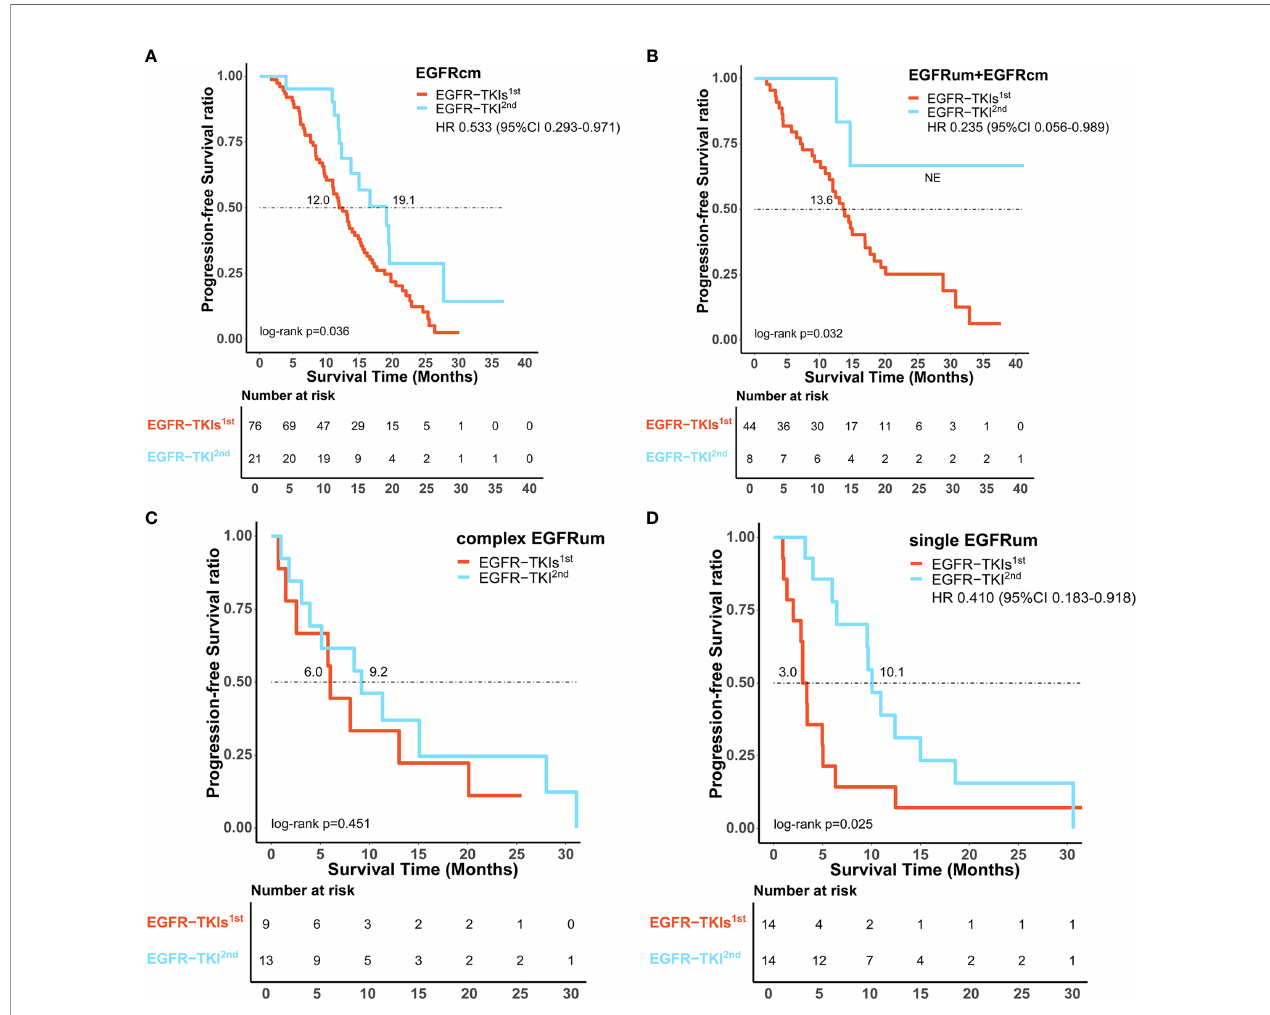
FIGURE 4 | Comparison of survival outcomes between fi rst-line therapy of ge fi tinib/erlotinib/icotinib ( EGFR -TKIs 1st ) and afatinib ( EGFR -TKI 2nd ). Afatinib showed signi fi cantly improved progression-free survival bene fi t over ge fi tinib/erlotinib/icotinib in patients subtypes of EGFR cm (A) , EGFR um+ EGFR cm (B) , and single EGFR um (D) , but comparable median progression-free survival in the complex EGFR um group (C) . EGFR cm, common EGFR mutations; EGFR um, uncommon EGFR mutations; HR, hazard ratio; 95% CI, 95% con fi dence interval.